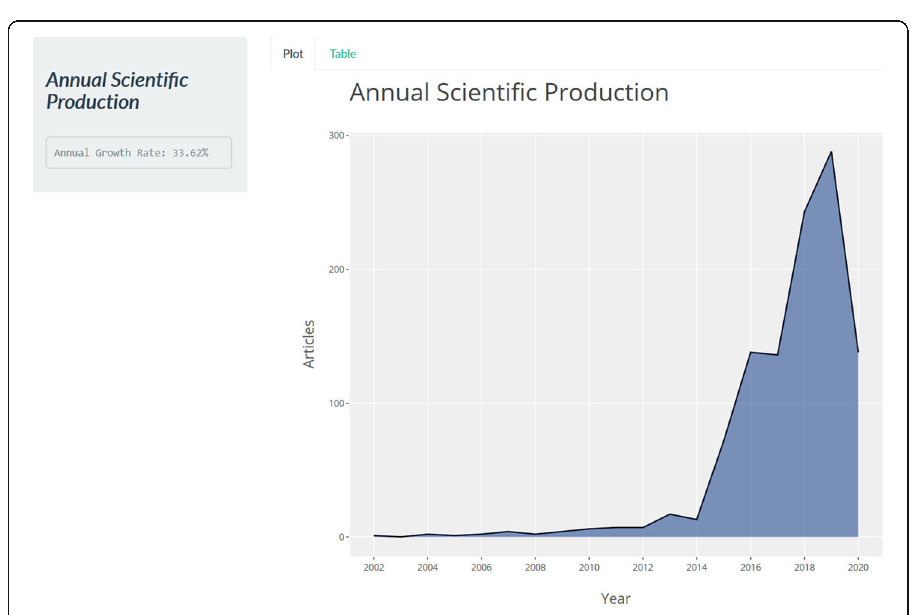
Fig. 1 Annual scientific growth of smart learning environments: A compound annual growth rate computed by R- package, a geometric progression ratio with a constant scientific production rate over a